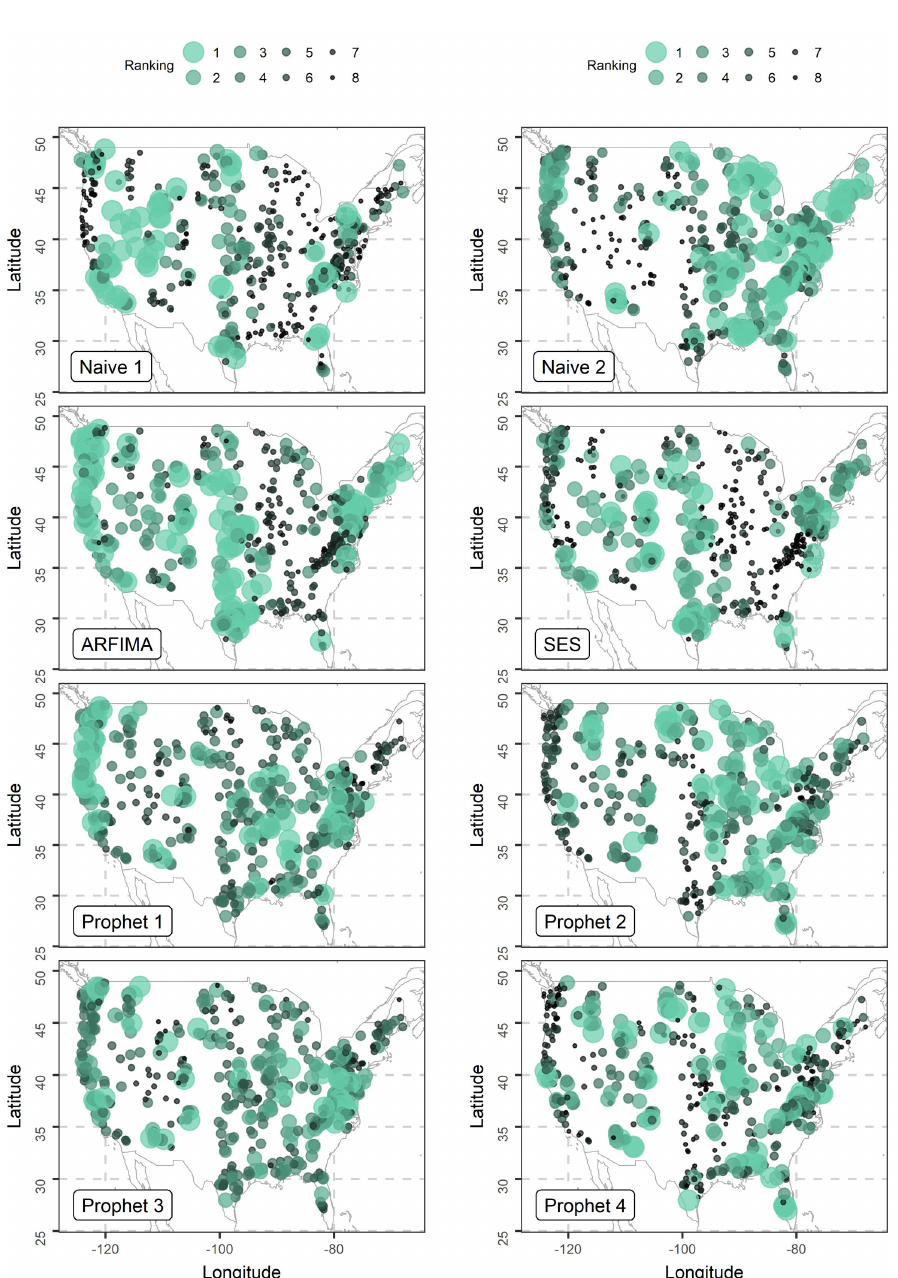
Figure 4. Rankings of the algorithms according to the RMSE metric. The algorithms are ranked from best (1st) to worst